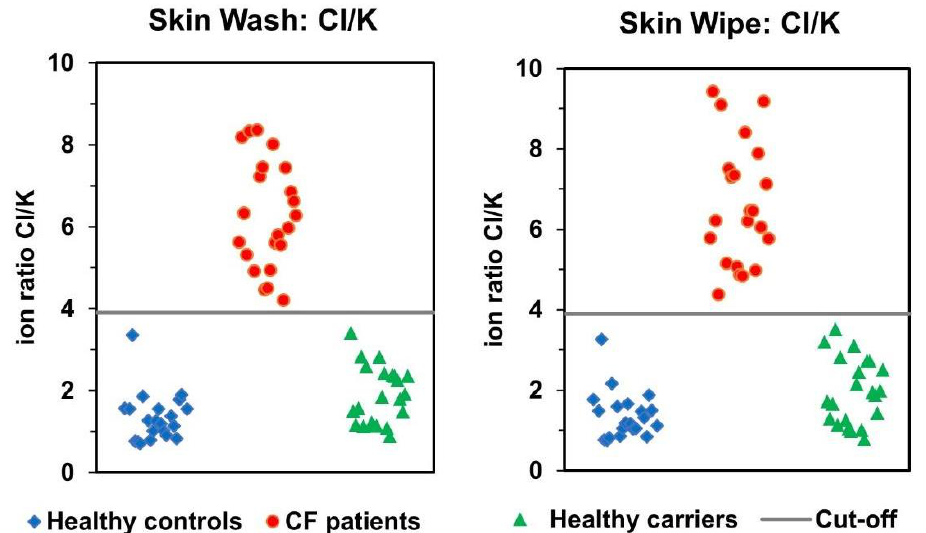
Figure 4. Comparison of Cl − /K + ion ratio from skin-wash and skin-wipe samples. Both datasets were obtained from the same persons, sampling was performed at the same time using both forearms. Each data point is an average of two samples taken from right and left